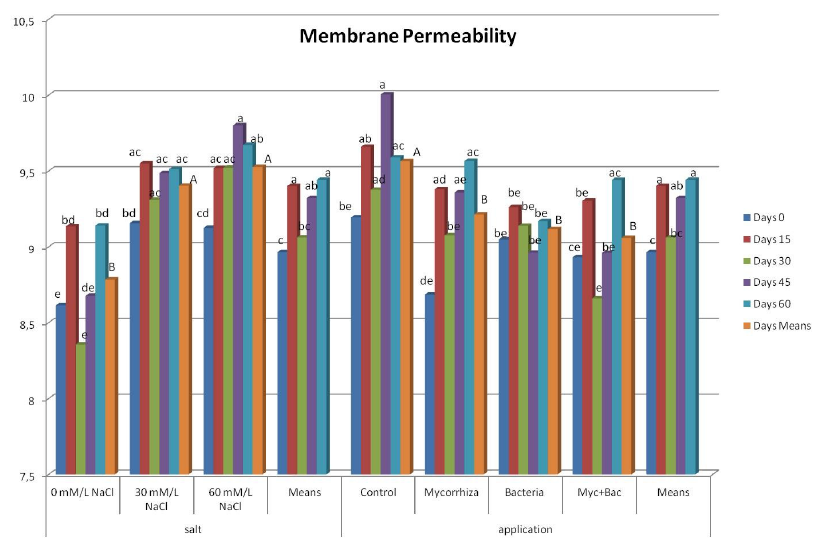
Fig. 6: Membrane permeability in the leaf tissues of strawberry cv. ‘San Andreas’ plants under salt (0, 30 and 60 mM/L NaCl) stress and applications (control, mycorrhiza, bacteria and myc+bac) for the periods of 0, 15, 30, 45 and 60 days.